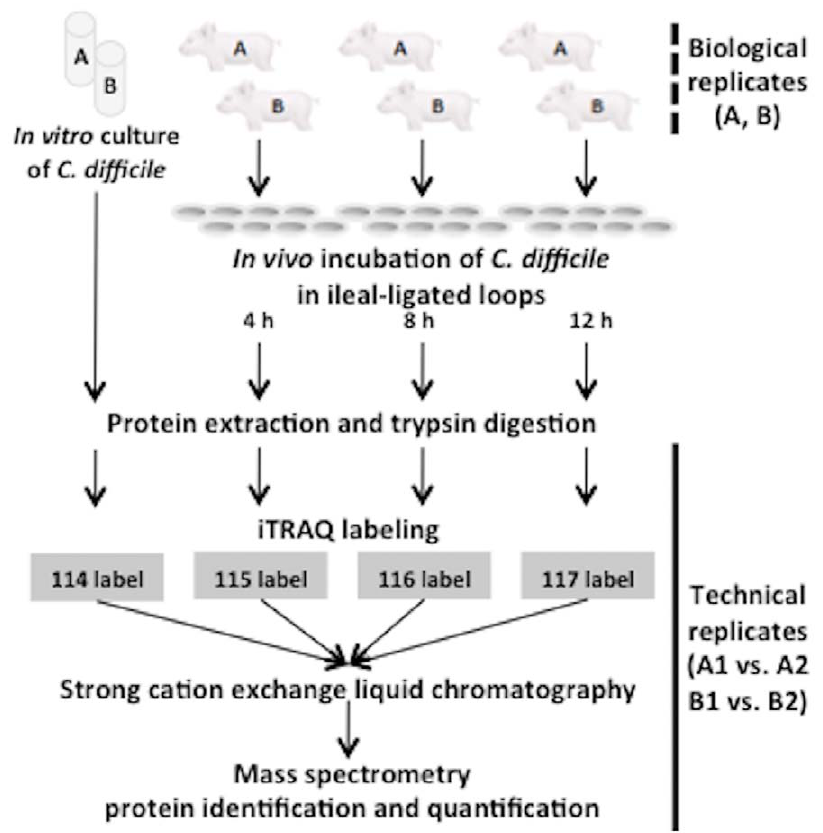
Figure 2. Overview of the experimental workflow. C. difficile retrieved from pig ileal-ligated loops following the in vivo incubation for a period of 4, 8 and 12 h were used for biological replicates (dotted line; A and B). The in vitro cultures of C. difficile were used as a control and subjected to the identical workflow. Proteins extracted from the control and the loop contents after 4, 8 and 12 h incubation were subjected to trypsin digestion and were labeled with the tags 114, 115, 116, and 117, respectively. Mass spectrometric results were analyzed for protein identification and quantification. Technical replicates were performed from the trypsin digestion step (solid line; A1 versus A2 and B1 versus B2).